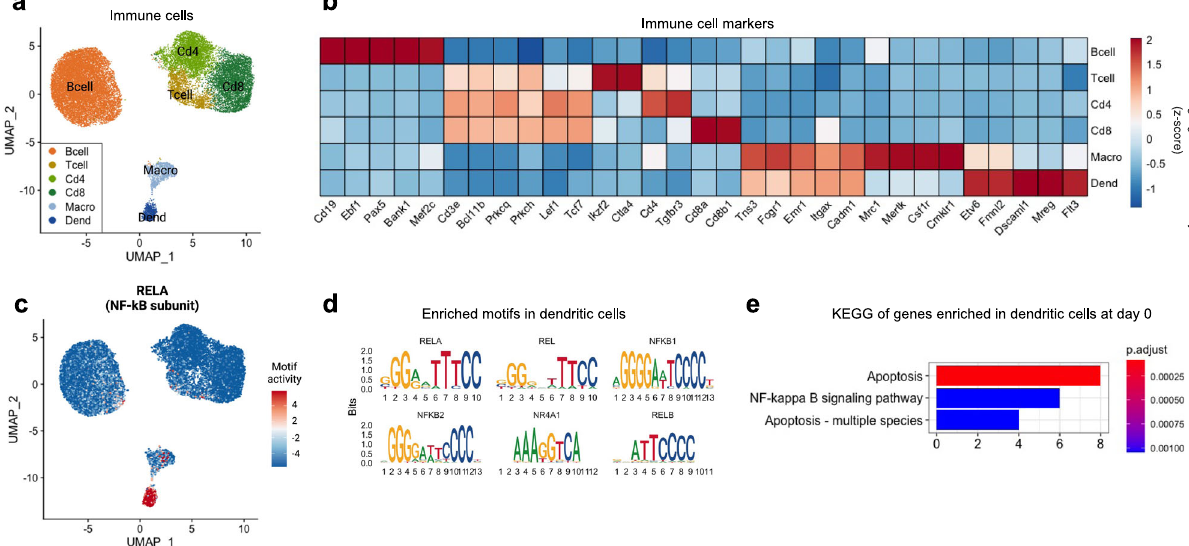
Fig. 6 Alterations in pro-in fl ammatory immune cell compartment. a UMAP of immune cell populations ( n = 23,687). b Heatmap of scaled gene accessibility for cell-type markers. c UMAP of RELA motif enrichment. d Motif sequences enriched in dendritic cell population. e GO analysis of genes enriched in dendritic cells at day 0 RT. X-axis indicates number of genes. Color indicates adjusted p -value. Macro Macrophage, Dend Dendritic